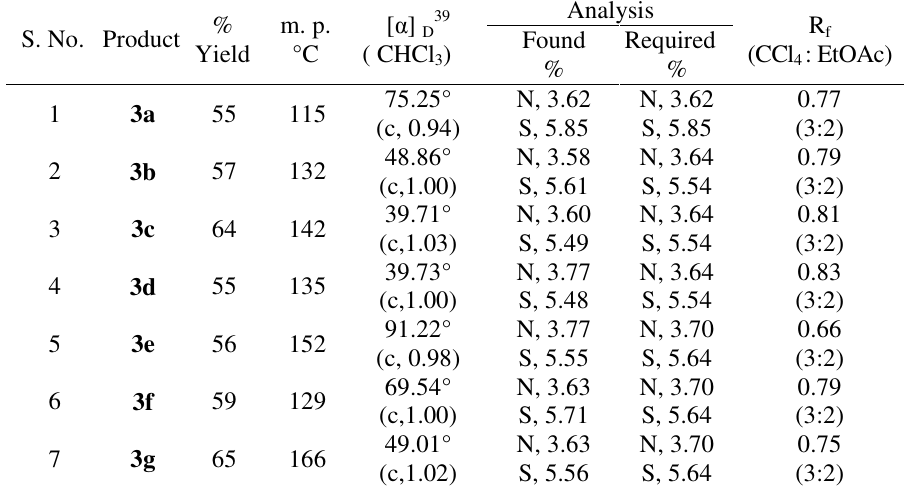
Table 1. Characterization data of the synthesized products